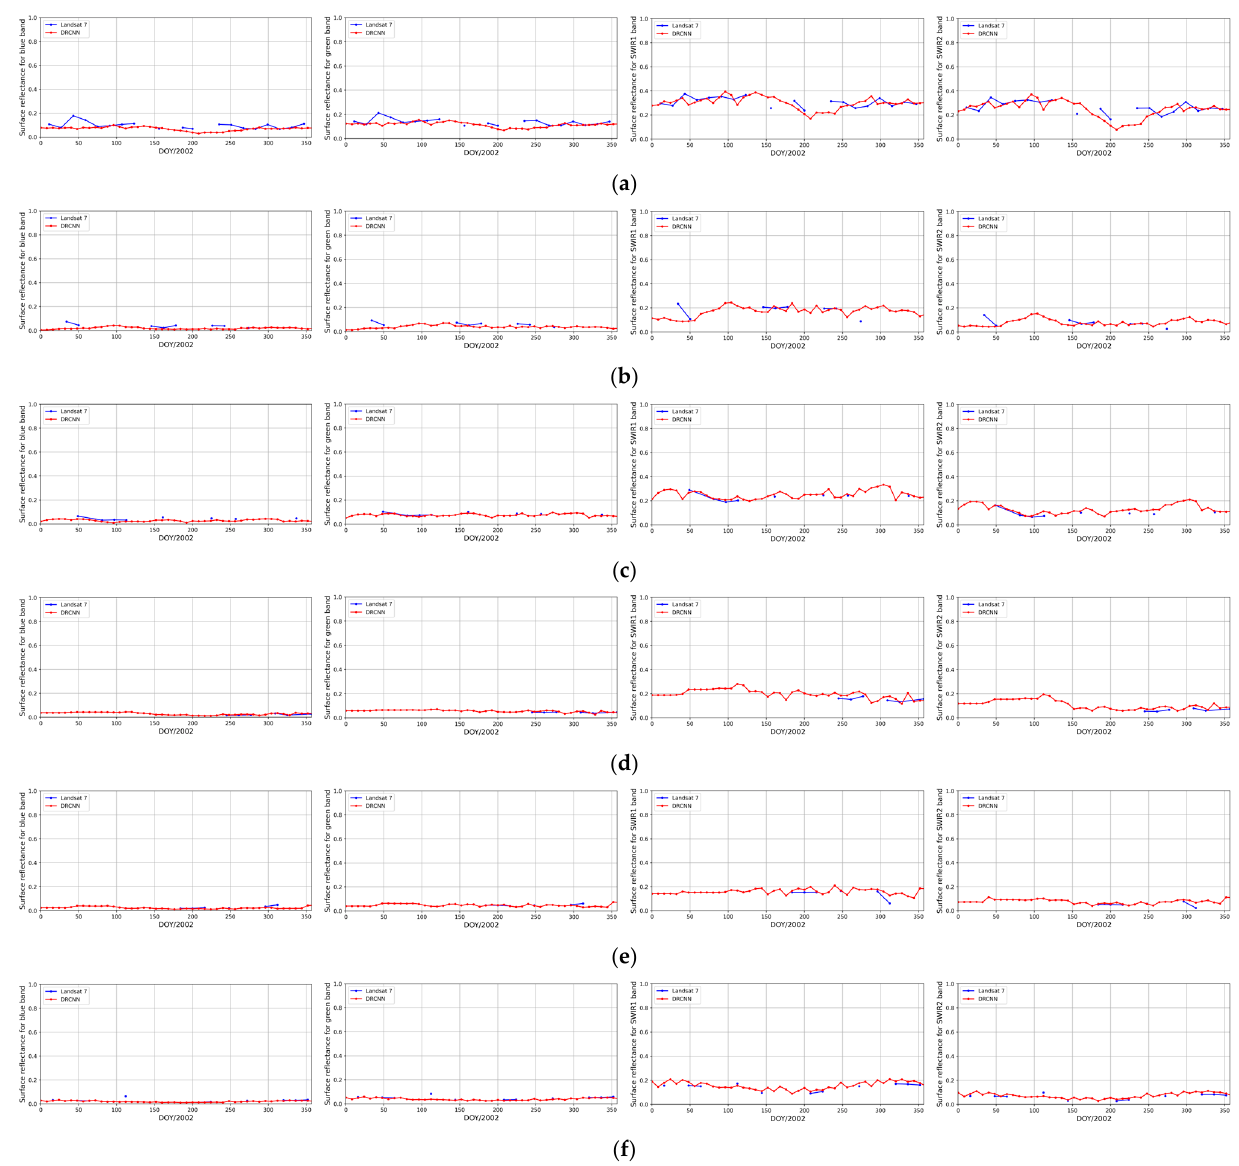
Figure 11. Time series of the downscaled surface reflectance from the DRCNN and the surface reflectance from Landsat 7 in the blue, green, SWIR1 and SWIR2 bands in 2002 at ( a ) the Zhangbei site, ( b ) the Collelongo site, ( c ) the Barrax site, ( d ) the Counami site, ( e ) the Larose site and ( f ) the Camerons site.